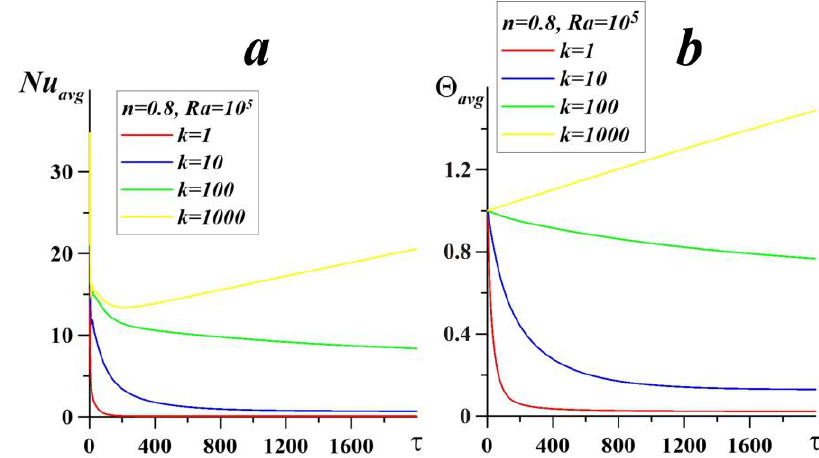
Figure 10. The time dependences of the average Nusselt number ( a ) and average temperature ( b ) at n = 0.8, Pr = 100, Ra = 10 5 and different k.